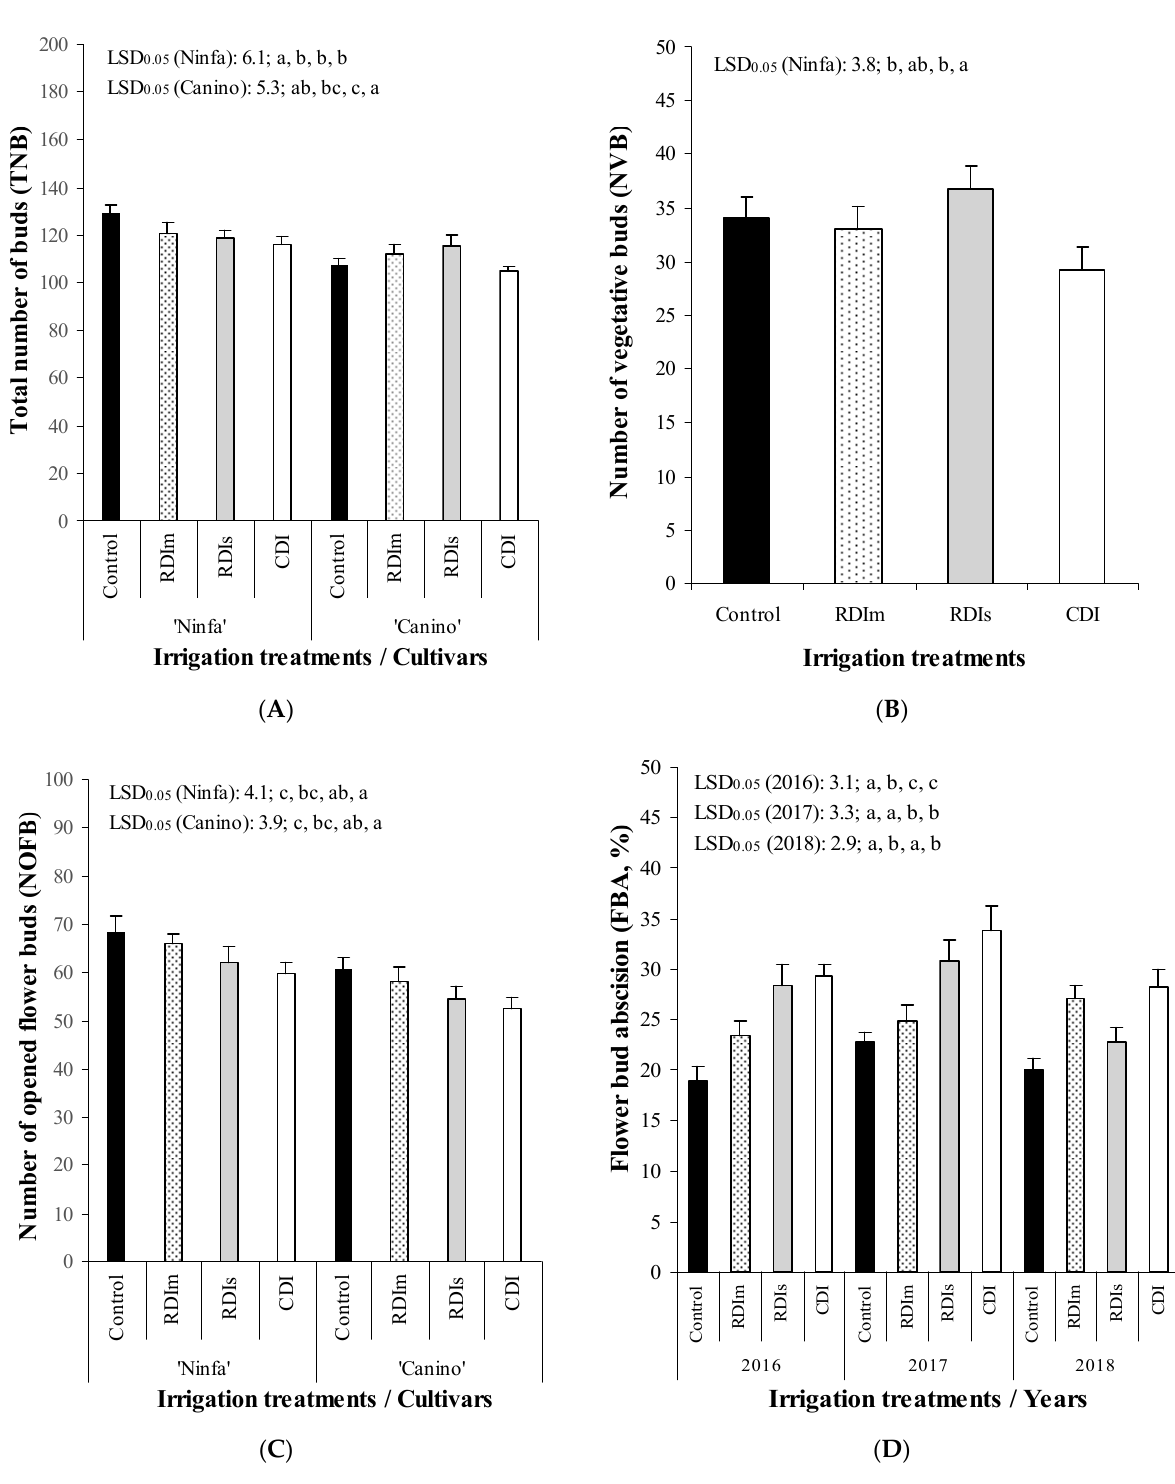
Figure 5. The effect of four irrigation treatments (control, moderate regular deficit irrigation—RDIm, severe regular deficit irrigation—RDIs and continuous deficit irrigation—CDI) on four bud related measures. ( A ) total number of buds—TNB versus (vs.) four irrigation treatments and two cultivars, ( B ) number of vegetative buds—NVB vs. four irrigation treatments, ( C ) number of opened flower buds—NOFB vs. four irrigation treatments and two cultivars and ( D ) flower bud abscission—FBA% vs. four irrigation treatments and three years. The two cultivars are ‘Ninfa’ and ‘Canino’. Explanation for standard deviation values, irrigation treatments, calculations of significant differences, and explanations for LSD 0.05 values are given in Figure 3.